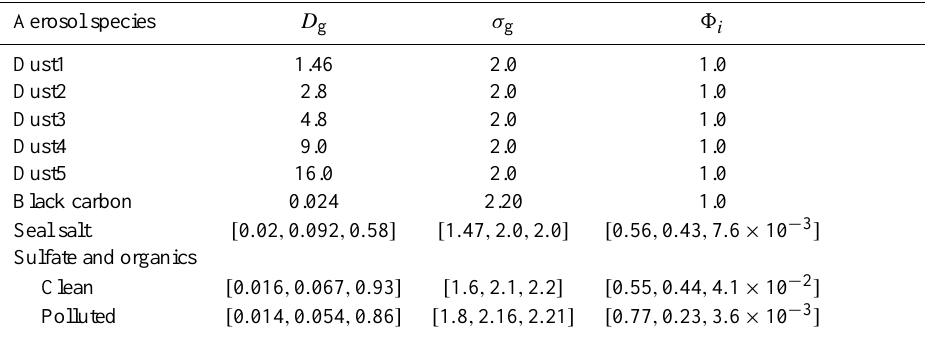
Table 1. Log-normal size distribution parameters used in this study (Lance et al., 2004). D g (µm) and σ g are the geometric mean diameter and dispersion, respectively. 8 i is the particle number fraction in mode i . The “polluted” size distribution parameters for sulfate and organics are used when the total aerosol mass exceeds 5.0µgm − 3